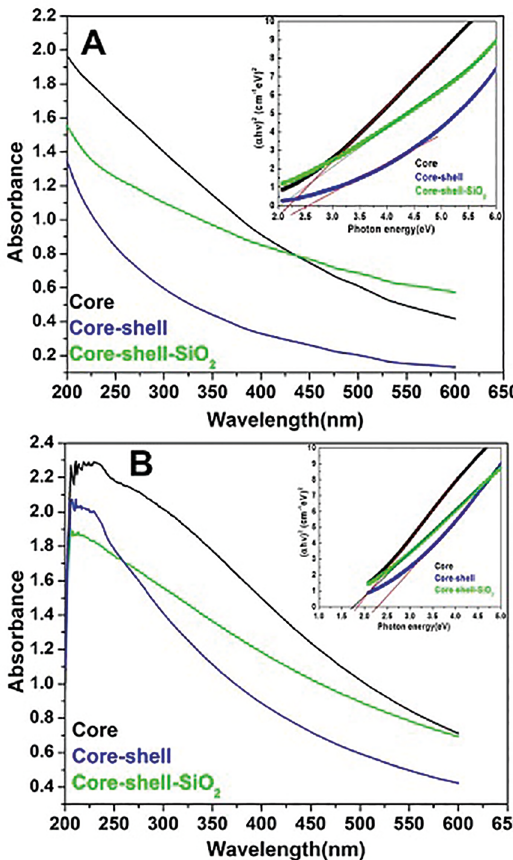
Figure 5. (A). UV-Vis absorption spectra of core, core-shell and microspheres in de-ionized water and inset shows core-shell-SiO 2 the plot of (αhν) 2 vs. photon energy(hν) of core, core-shell and microspheres. (B). UV-vis absorption spectra of core-shell-SiO 2 core, core-shell and core-shell-SiO microspheres in absolute ethanol 2 and inset shows the plot of (αhν) 2 vs. photon energy(hν) of core, microspheres. core-shell and core-shell-SiO 2